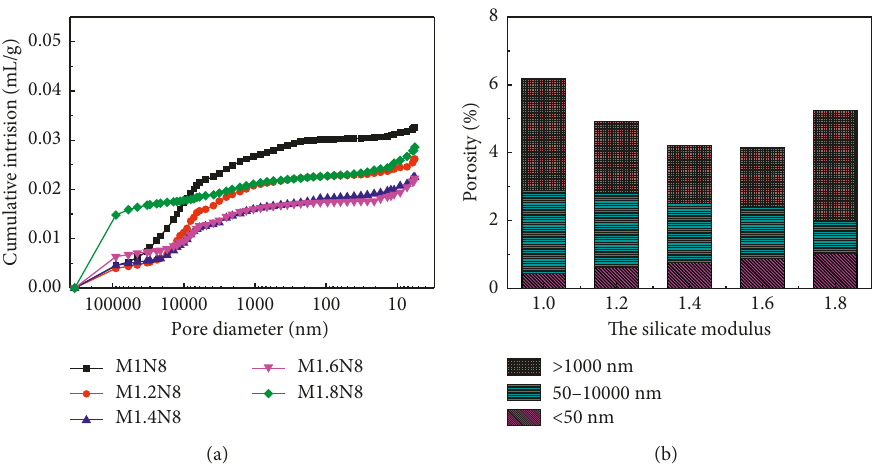
Figure 10: Pore size distribution of AAS pastes with different silicate moduli: (a) cumulative intrusion; (b)